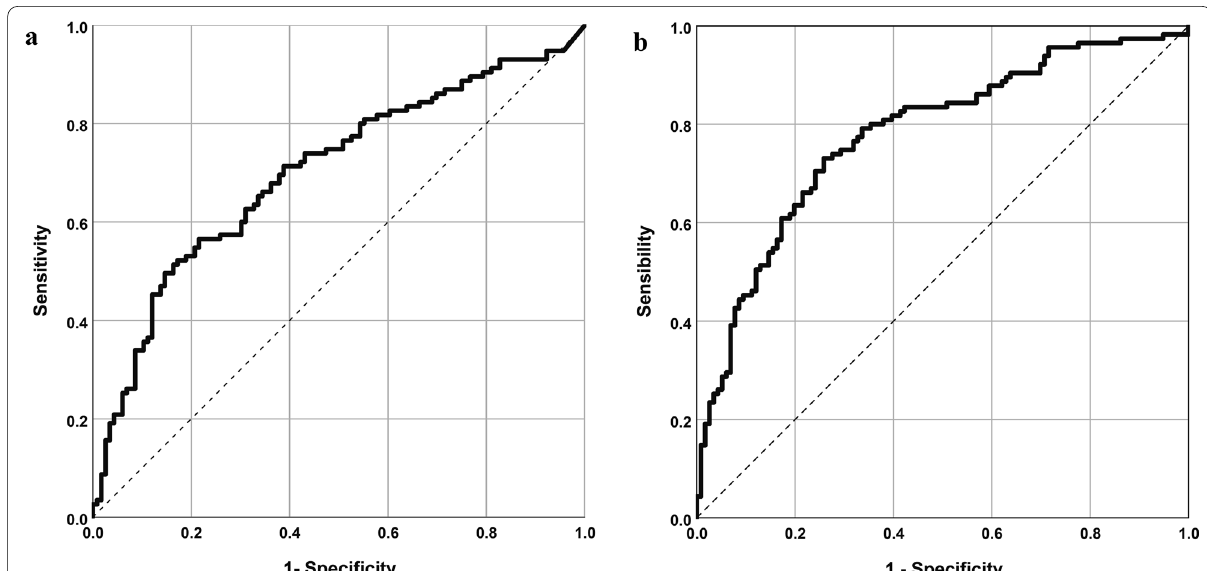
Fig. 1 Receiver operating characteristic curve illustrating the ability to predict intra‑dialytic hypotension during the first intermittent renal replacement therapy session after discontinuation of continuous renal replacement therapy (CRRT). A Multivariable model combining variables available at CRRT discontinuation (AUC: 0.70 CI: 0.63; 0.77 p < 0.001). B Multivariable model combining variables available immediately before IRRT initiation (AUC: 0.78 CI: 0.72; 0.84 p < 0.001